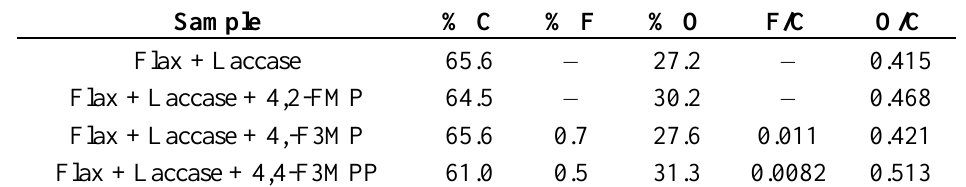
Table 1. XPS analysis of coconut fibers after laccase treatment with different fluorophenols.